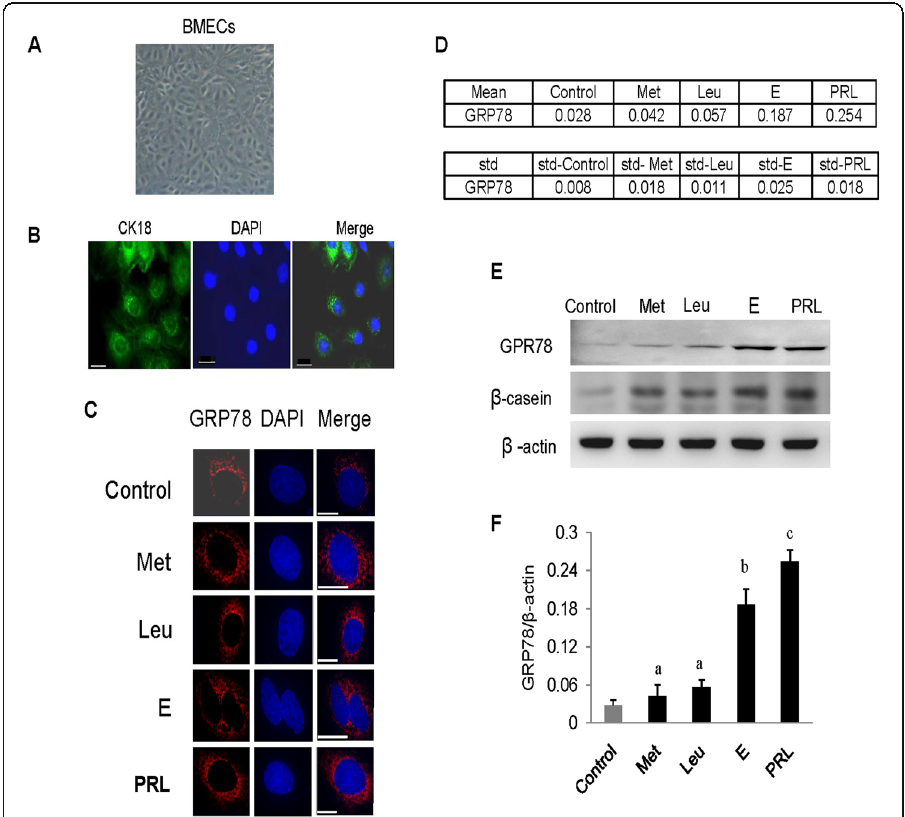
Fig. 1 Certain amino acids and hormones trigger GRP78 expression. a Microscopic morphologyof the purified cells. Scale bar: 75 μ m. b Detection of CK18 in BMECs. CK18 (green), DAPI (blue), scale bar: 25 μ m. c Subcellular localization of GRP78 in cells treated with the essential amino acids Met and Leu and the hormones estrogen ( e ) or prolactin (PRL). Nuclei (blue), GRP78(red), scale bar: 10 μ m. d AIOD of GRP78 expression per cell from ( b ) was analyzed using ImageJ. Ten cells were analyzed per sample. The AIOD of the control was set as 1.00 for clarity. e The protein levels of GRP78 and β -casein in the cells were determined using western blotting after treatments with methionine (Met), leucine (Leu), estrogen ( e ) or prolactin (PRL); β -actin served as the loading control. f The relative fold changes in the protein levels of GRP78 (protein/ β -actin) in ( e ) were quantified with grayscale scanning. The data represent the means±SE from three independent experiments. Values with different superscripted lowercase letters indicate significant difference ( p <